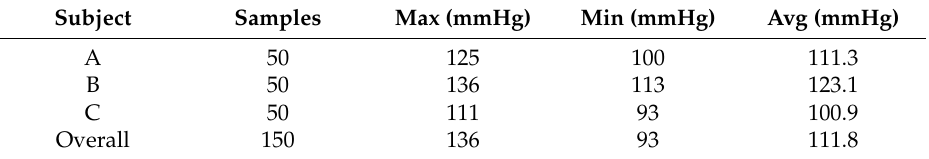
Table 1. Calibration data set of each subject.